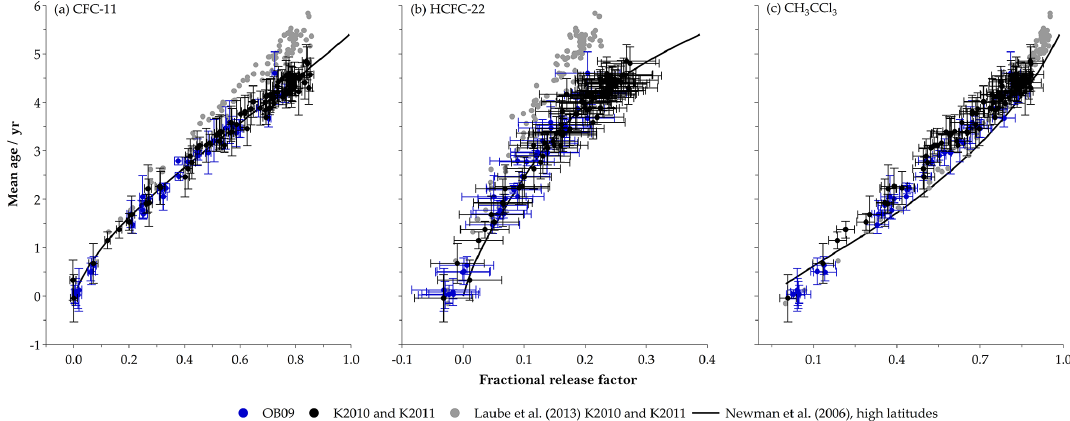
Figure 5. Changes in FRFs resulting from our new “best-estimate” mean age of air and the improved FRF calculation method from Oster- möller et al. (2017) for OB09, K2010 and K2011 compared to previously published K2010 and K2011 data (Laube et al., 2013) and FRF mean age correlations from Newman et al. (2006). Shown for three compound case studies; see details in the main text of the paper. Table 7. Updated ODPs based on “best-estimate” mean ages (taken at 3 years) derived in this study compared to existing literature values. Numbers in brackets are min–max ∗